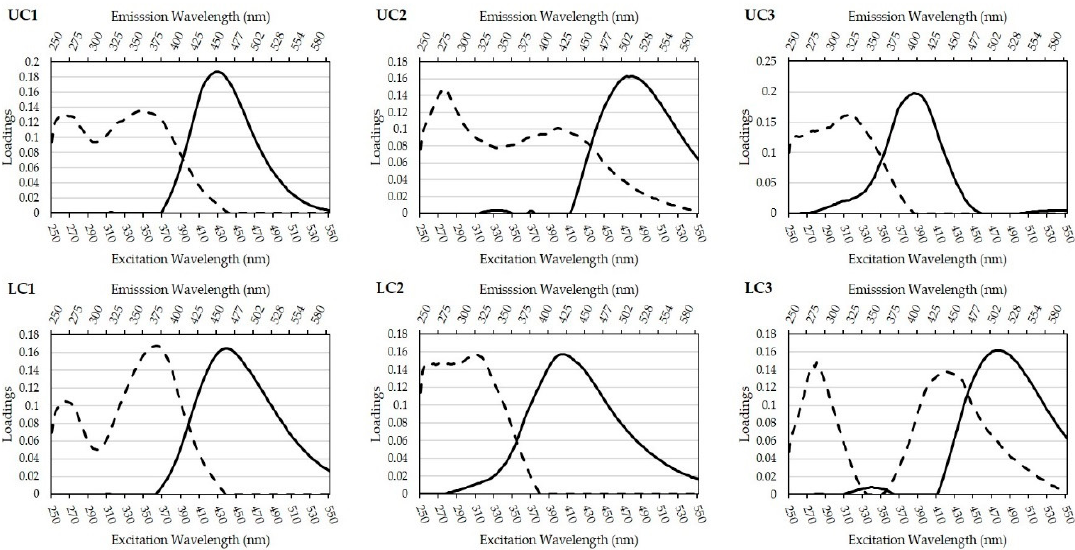
Figure 2. Excitation (dashed lines) versus emission (solid lines) loadings for the upland (UC1–UC3) and lake (LC1–LC3) parallel factor analysis (PARAFAC) models.